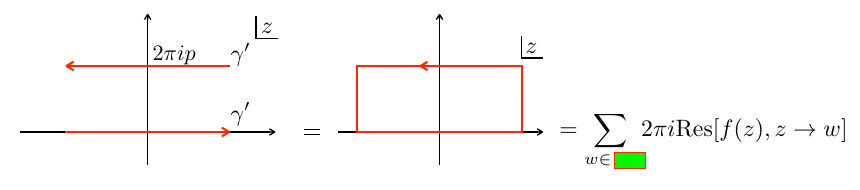
Figure 2 . Contour γ 0 used in (4.30) and its